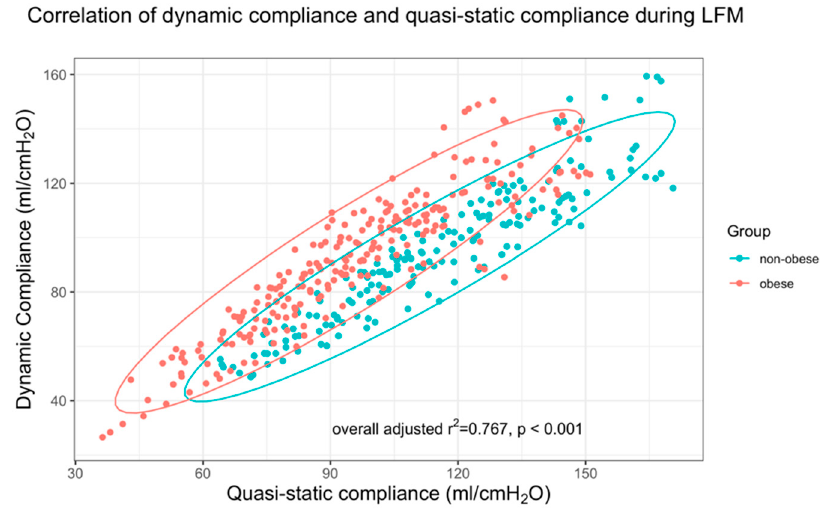
Figure 4. Correlation between dynamic compliance and quasi-static compliance of the respiratory system during the inspiratory limb of the low-flow maneuver (LFM)-based on the data calculated using the least squares method. Dynamic compliance and quasi-static compliance during the LFM highly correlated in both obese and non-obese patients.